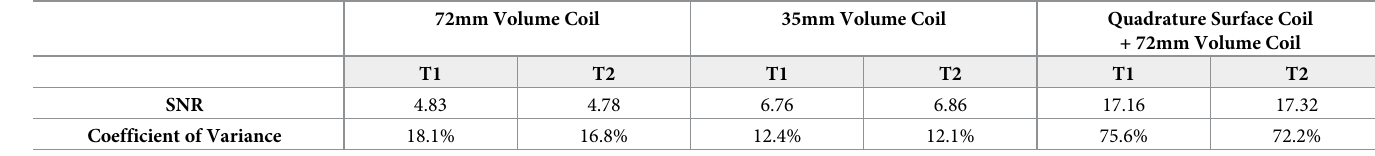
Table 2. Sensitivity and homogeneity of a uniform sample scanned with three rf coil configurations for small animal MR at